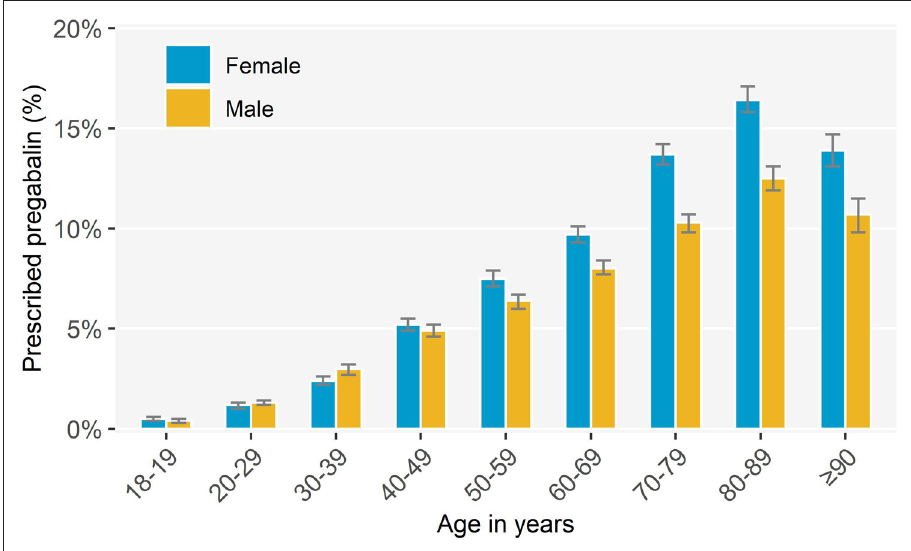
Figure 2 Proportion of active patients prescribed pregabalin by age group and sex, March 2012–February 2018 ( n = 114 123).